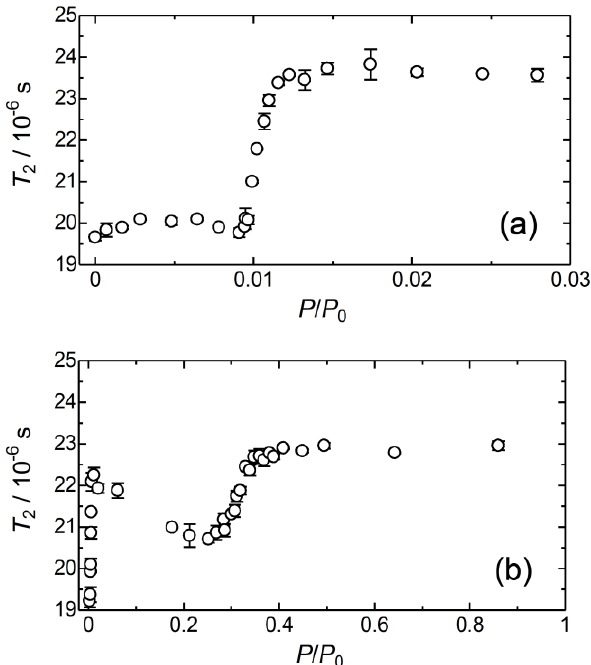
Figure 4. 1 H T 2 as a function of the relative pressure of CO 2 under sorption equilibrium with ELM-11 at: ( a ) 273 K and ( b ) 195 K.